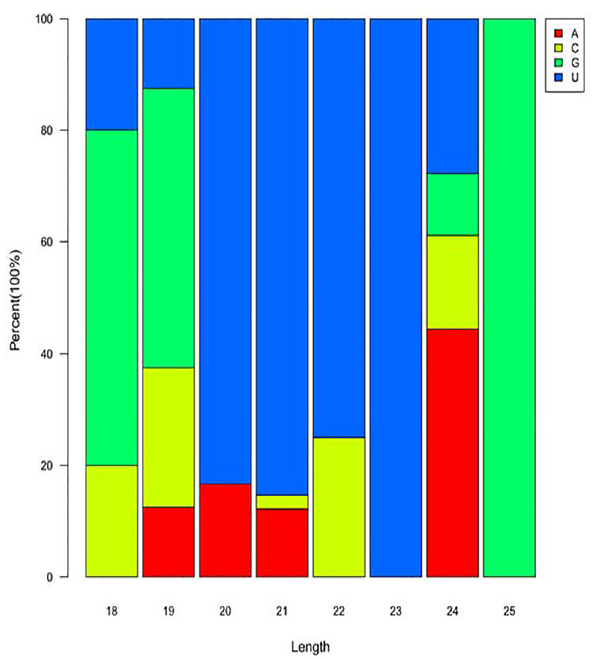
Fig 6. First nucleotide bias of known miRNAs in A . catenella . The figure indicates the first nucleotide of 18 – 25 nt miRNAs. U had the greatest frequency among miRNAs of 20 – 23